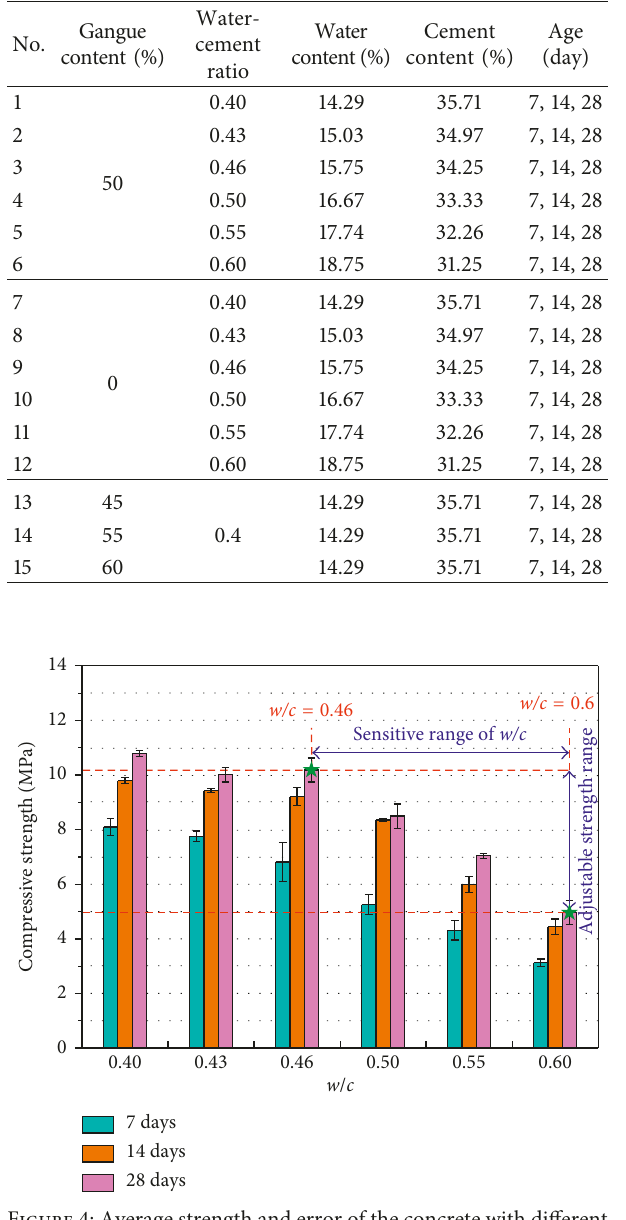
Figure 4: Average strength and error of the concrete with different water-cement ratios and a gangue content of 50%.